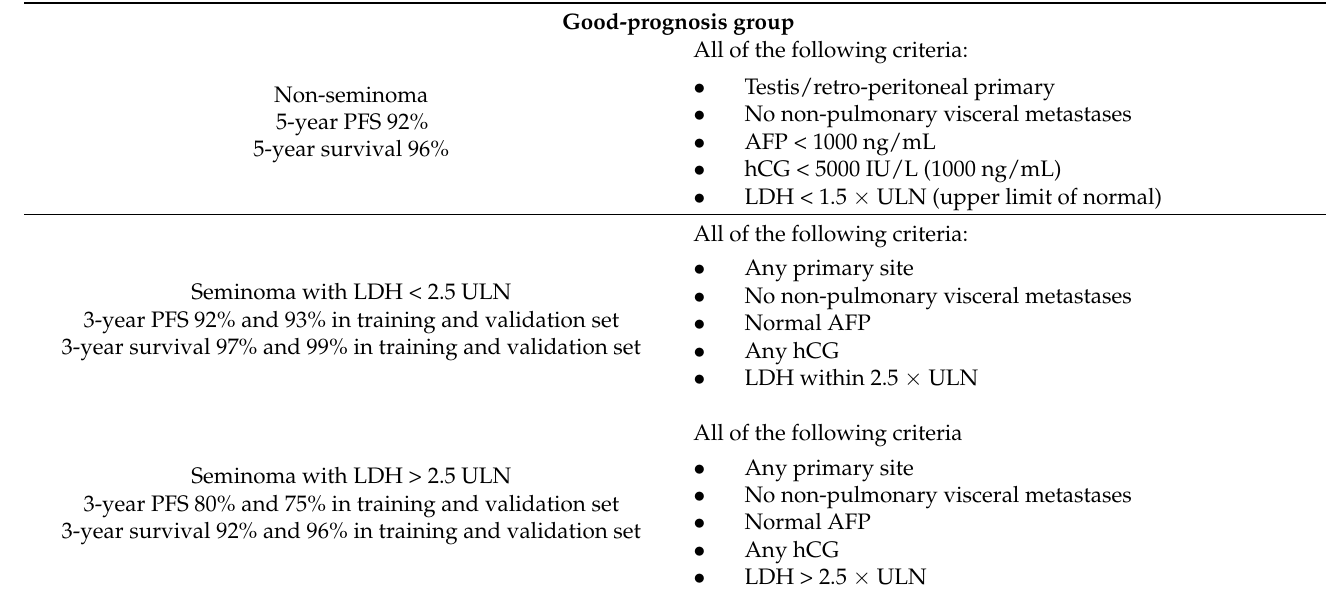
Table 3. Updated prognostic-based staging system for metastatic germ cell cancer (IGCCCG)